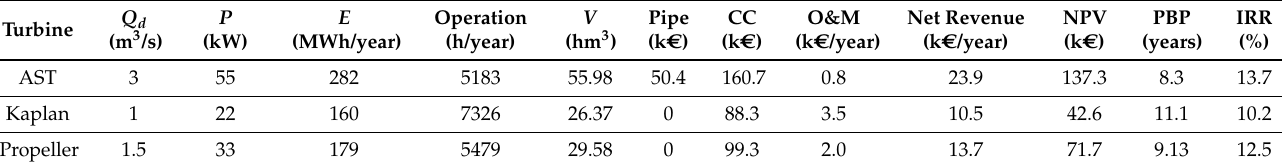
Table 1. Technical and economic parameters comparison of optimal solutions for each turbine.